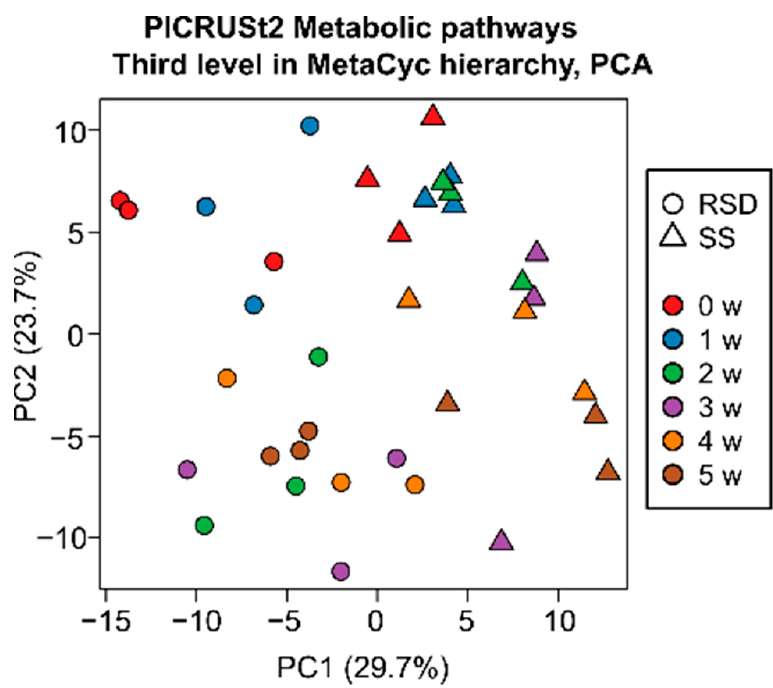
Figure 4. Principal component analysis (PCA) of the pathway composition (third level in MetaCyc hierarchy) predicted by PICRUSt2 in the soil bacterial metagenomes under ( ○ ) reductive soil disin- festation (RSD) and ( △ ) soil solarization (SS). Red, blue, green, purple, yellow, and brown denotes 0–5 w: treatment period for 0 to 5 weeks.